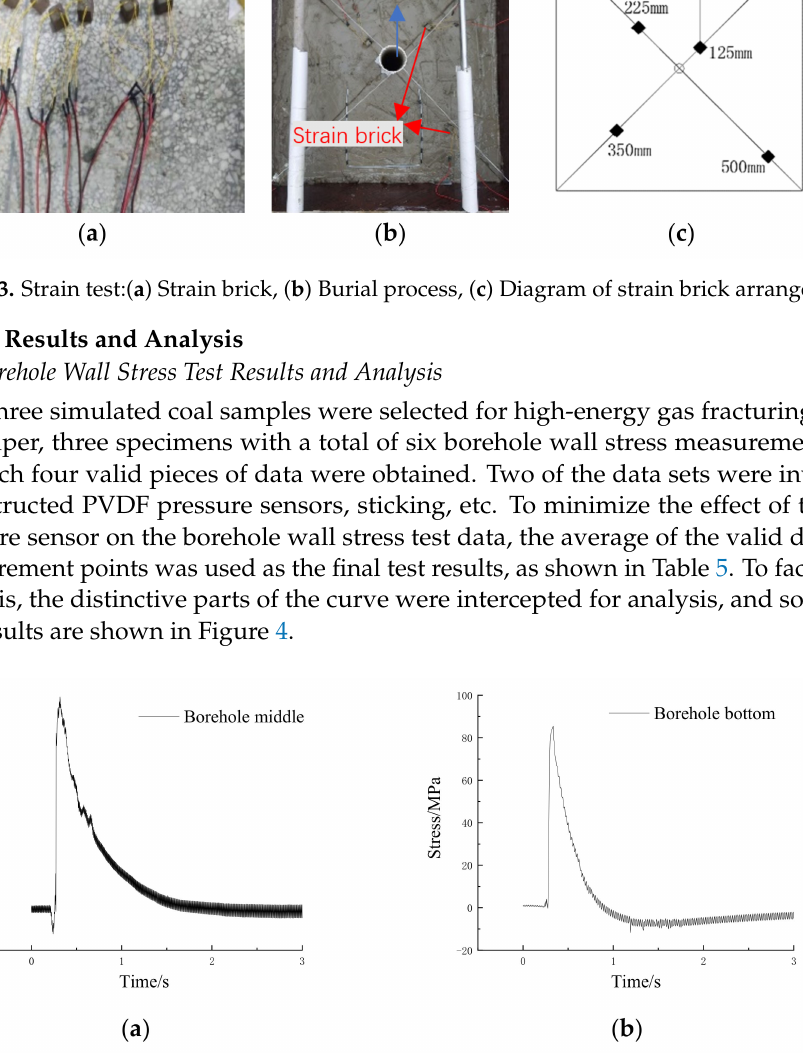
Figure 4. Pressure–time curve of the borehole wall: ( a ) Borehole middle, ( b )Borehole